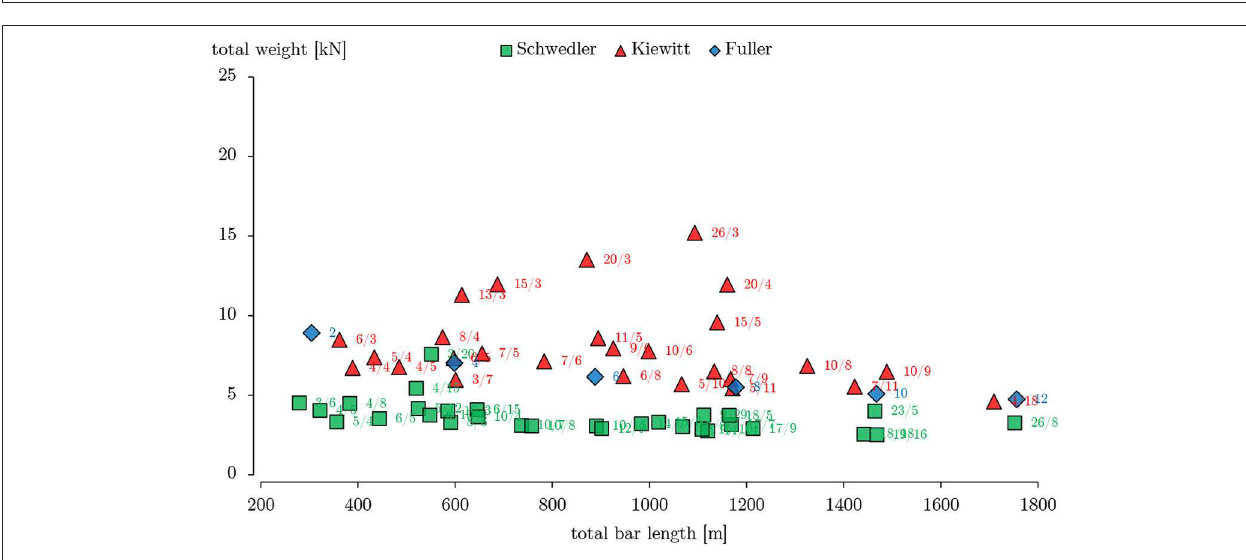
FIGURE 7 | Minimized weight of Schwedler, Kiewitt, and geodesic domes if each member is sized